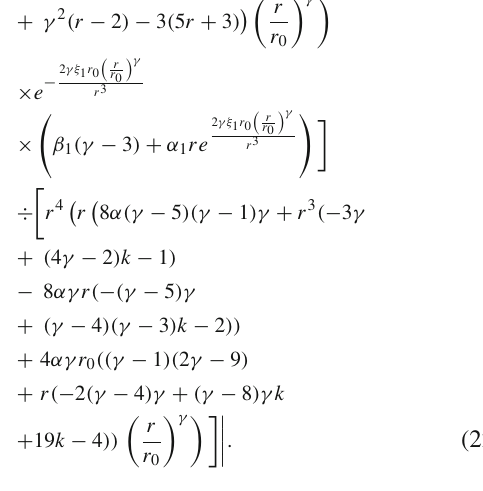
(cid:2) e ξ 1 R Discussion for Model-I: ρ = α 1 R + β 1 R The parameter α 1 , β 1 and ξ 1 are the controlling parameters (cid:2) e ξ 1 R . The function f ( R , T ) = for the model ρ = α 1 R + β 1 R R + α R 2 + 2 β ln ( T ) is dependent on constants α and β . The constant ξ 1 can be zero, positive or negative. So, there